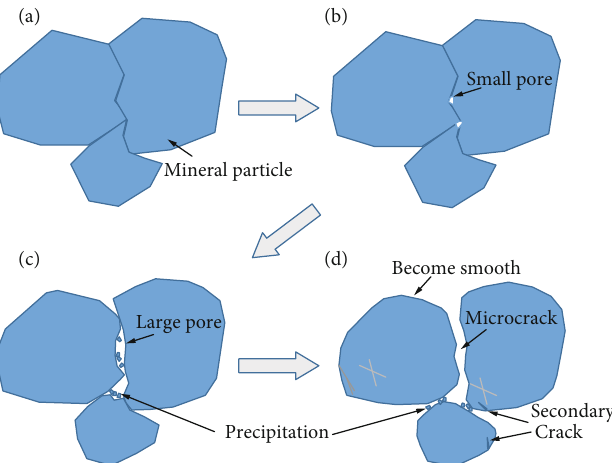
Figure 15: Diagrams of the microstructure development process after di ff erent wet-dry cycles. (a) 0 times; (b) 1-10 times; (c) 10-30 times; (d) > 30